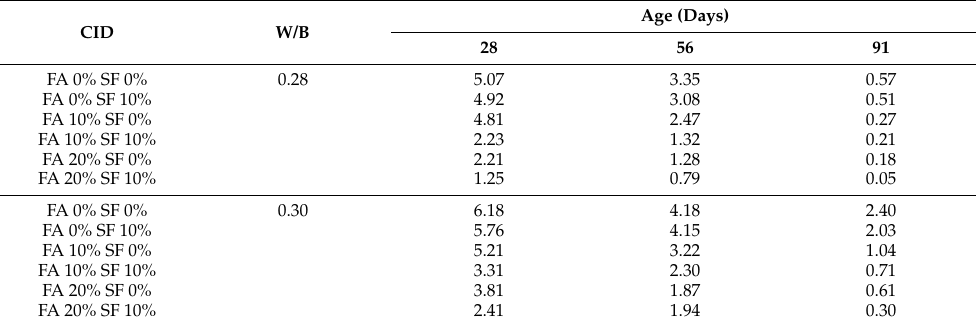
Table A4. Source data for tests on permeability to sulfate acid (LoW; unit: % of weight).